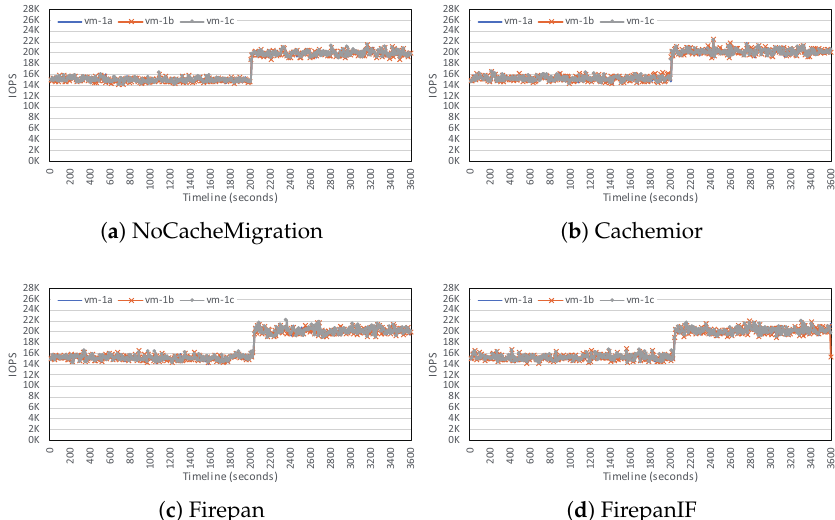
Figure 8. Performance of neighbor VMs on the source host with NoCacheMigration, Cachemior, Firepan, and